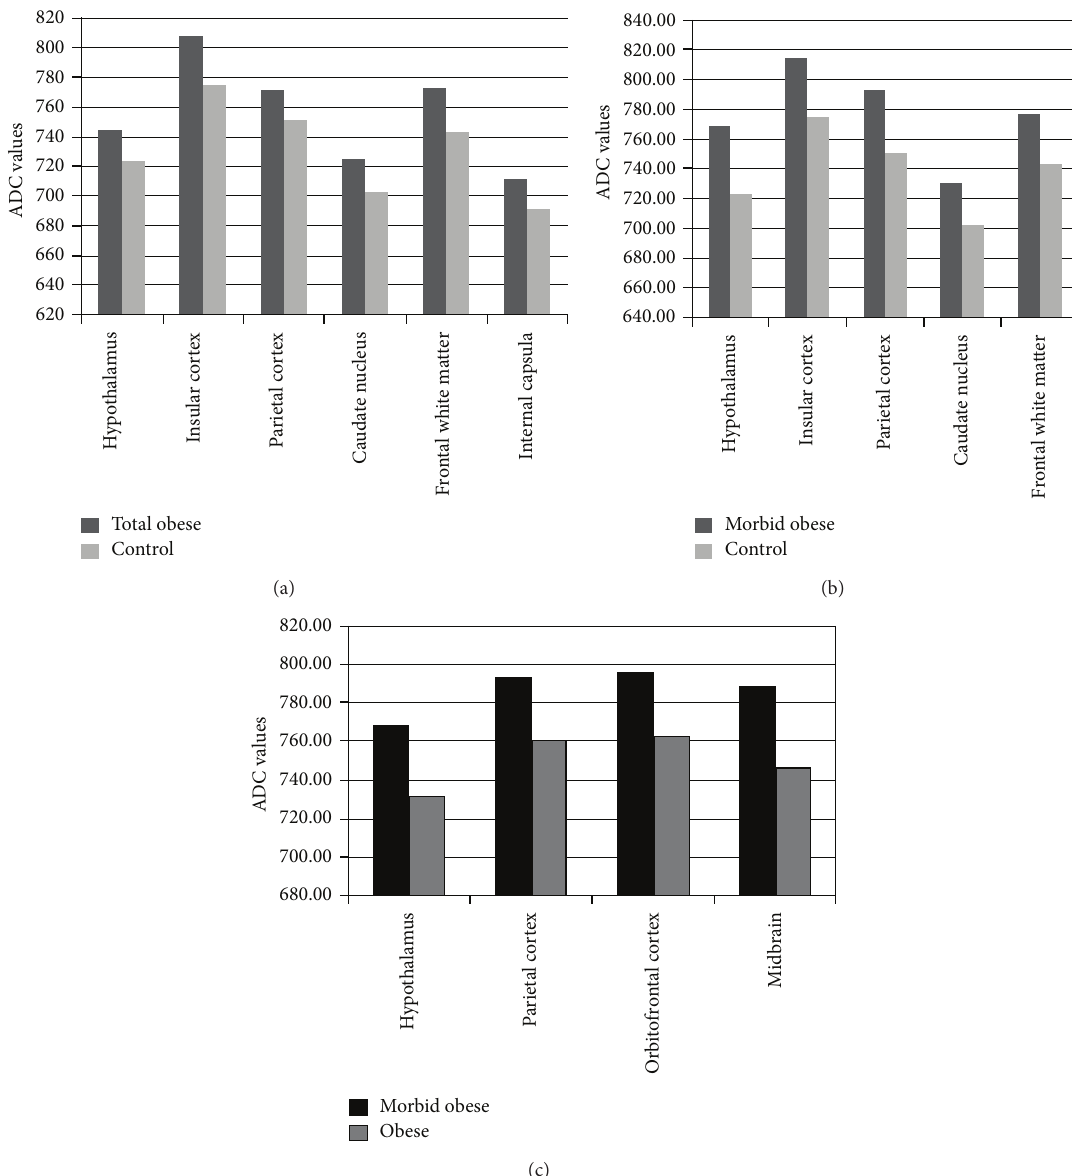
Figure 3: (a) The figure shows that the ADC values ( × 10 −6 mm 2 /s) in hypothalamus, insular cortex, parietal cortex, caudate nucleus, posterior limb of internal capsula, and frontal white matter were significantly increased in total obese patients compared to control group. (b) The figure shows that the ADC values ( × 10 −6 mm 2 /s) in hypothalamus, insular cortex, parietal cortex, caudate nucleus, and frontal white matter were significantly higher in morbid obese compared to control group. (c) The figure shows that the ADC values ( × 10 −6 mm 2 /s) in midbrain, hypothalamus, orbitofrontal cortex, and parietal cortex were significantly increased in morbid obese compared to obese patients.